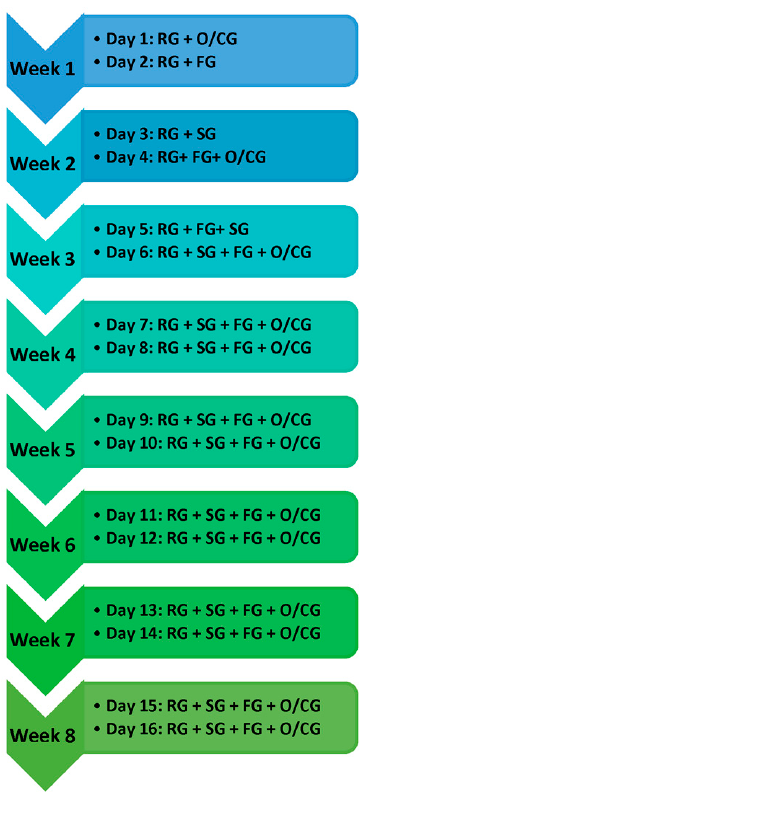
Figure 2. Experimental protocol. RG: reach game; SG: sequence game; FP: flip game; O/CG: opening/closing